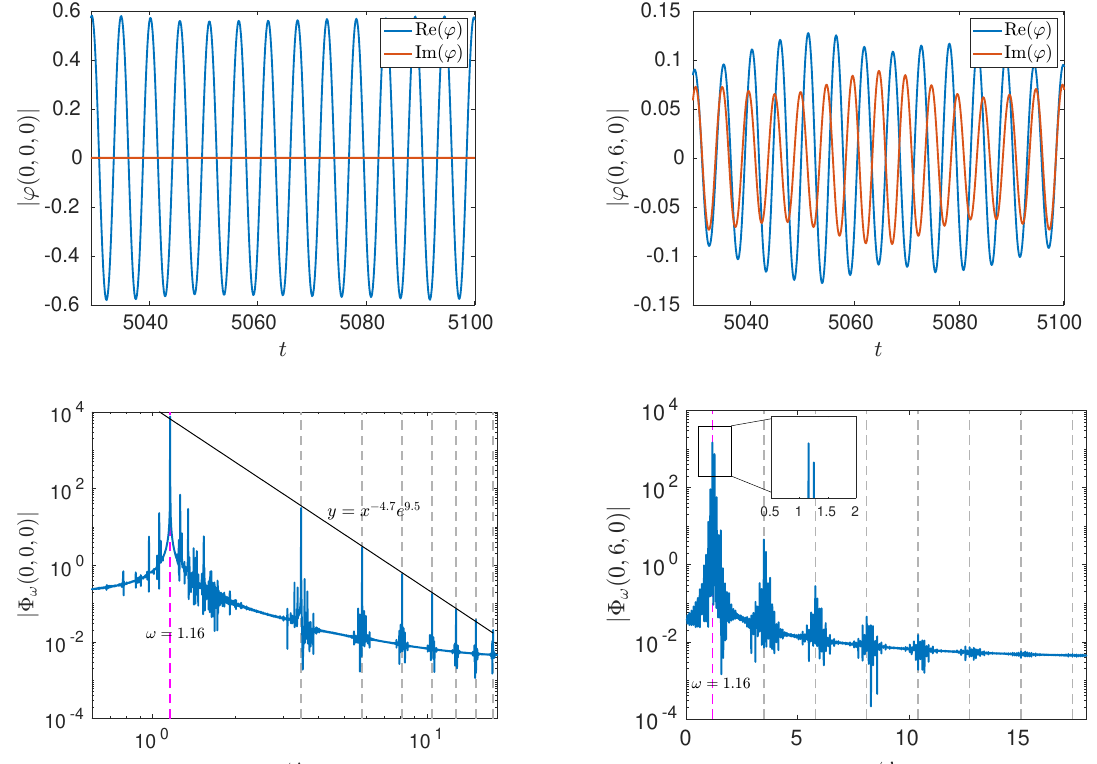
Figure 9 . Evolution of the field and its Fourier spectrum at two spatial points. The left column is at the center of the CSQ and the right column is at a point in the outer region of the CSQ. In the Fourier spectrum plots, the vertical dashed magenta lines show the base frequency and the vertical dashed gray lines show the odd multiples of the base frequency. In the inset of the bottom right plot, we can see two sub-peaks for the dominant peak, the difference between the two sub-peaks being the charge-swapping frequency of the